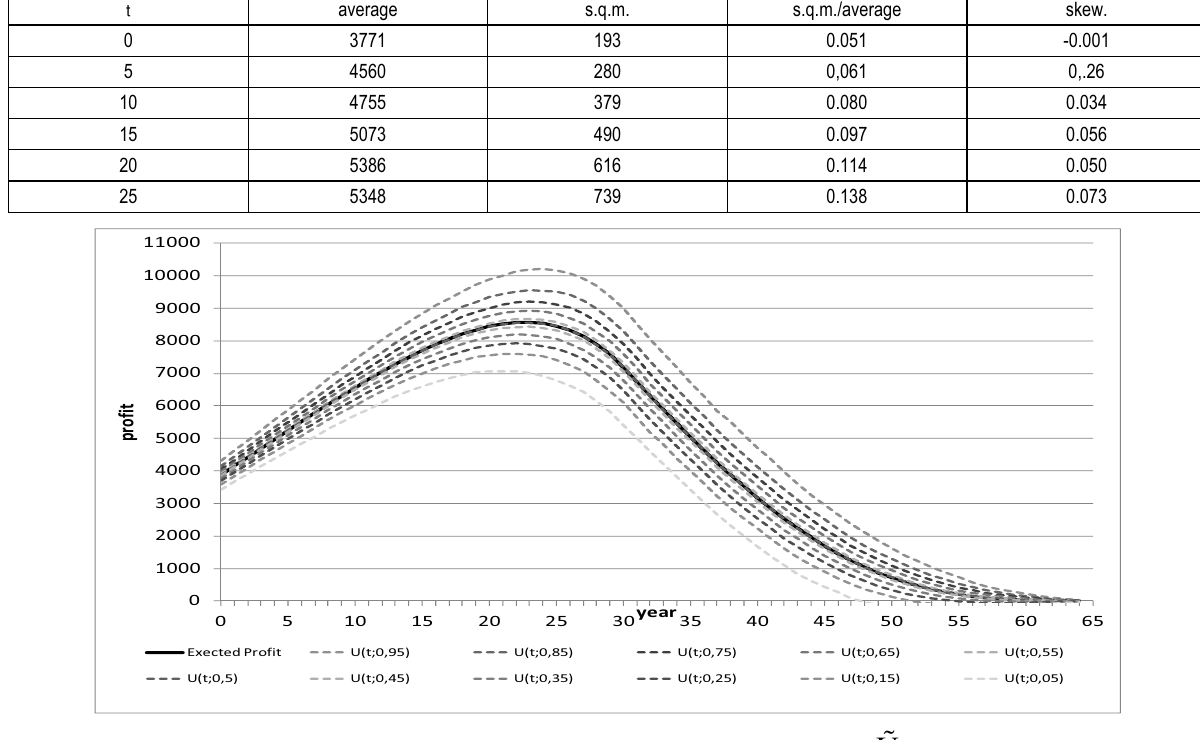
Fig. 1B. Average and percent values of the distributions of